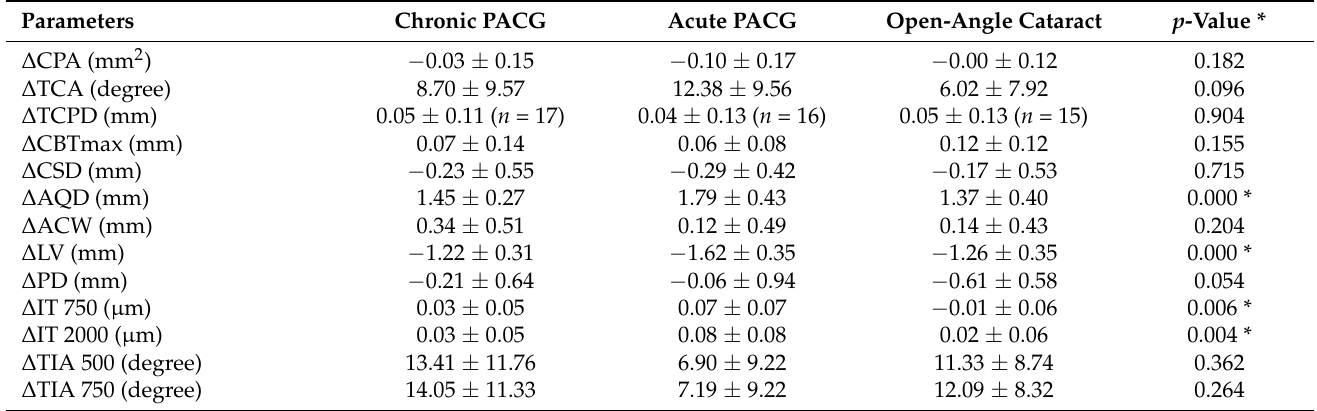
Table 2. The comparisons of the changes in the anterior segment parameters after cataract surgery among the three